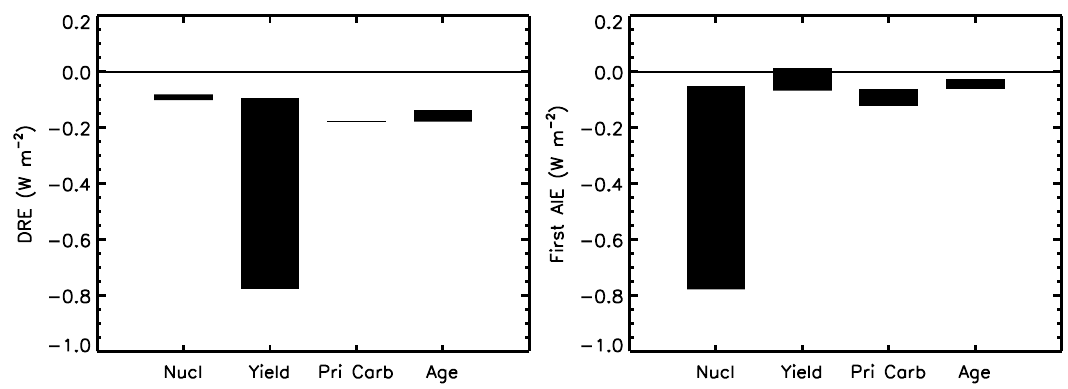
Fig. 8. Variation in global annual mean DRE (left) and first AIE (right) of biogenic SOA associated with several parameters; black bars indicate the range of values obtained for each set of experiments: Nucl (nucleation mechanism; expt. 2, 14, 16, 18), Yield (SOA yield; expt.